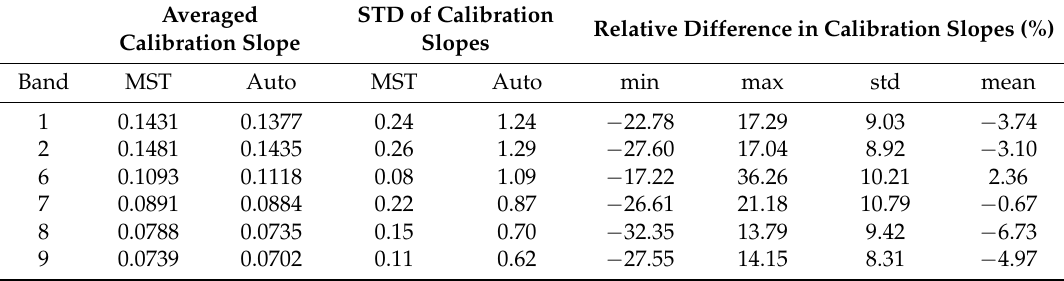
Table 3. Statistical summary of the calibration slope comparisons between the MST and automatic calibration